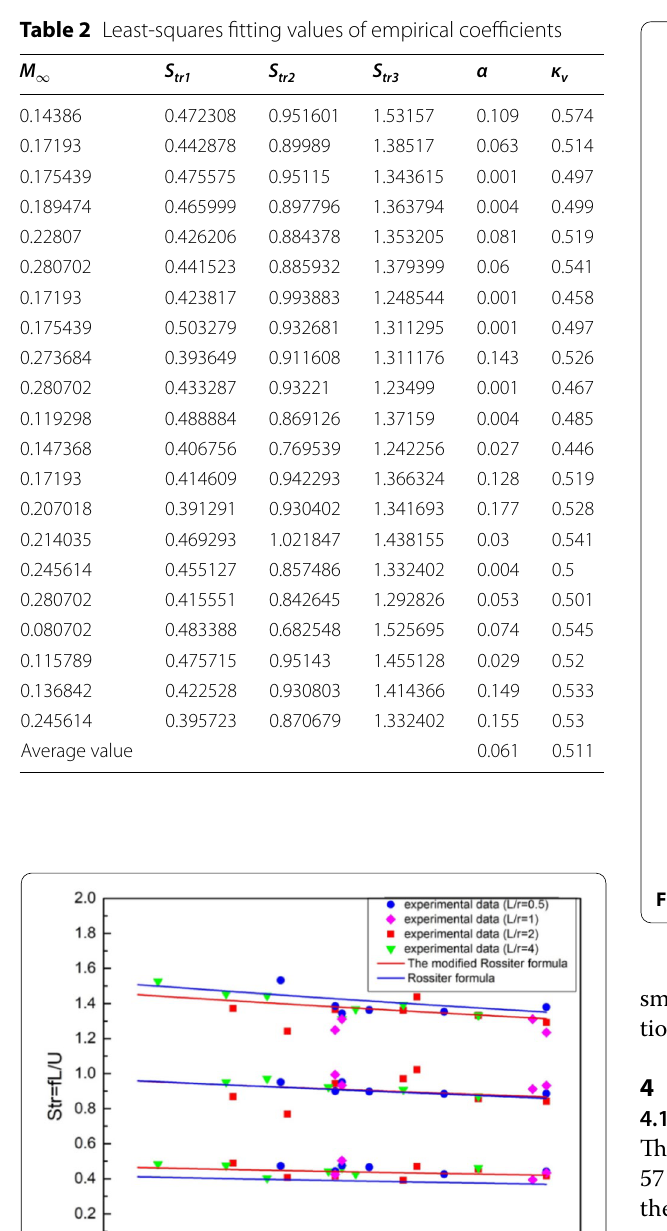
the pressure oscillation, as shown in Figure 7. The sound pressure level (SPL) is defined as follows: p SPL (dB) = 20 · log . 10 (cid:31) p ref (cid:30)